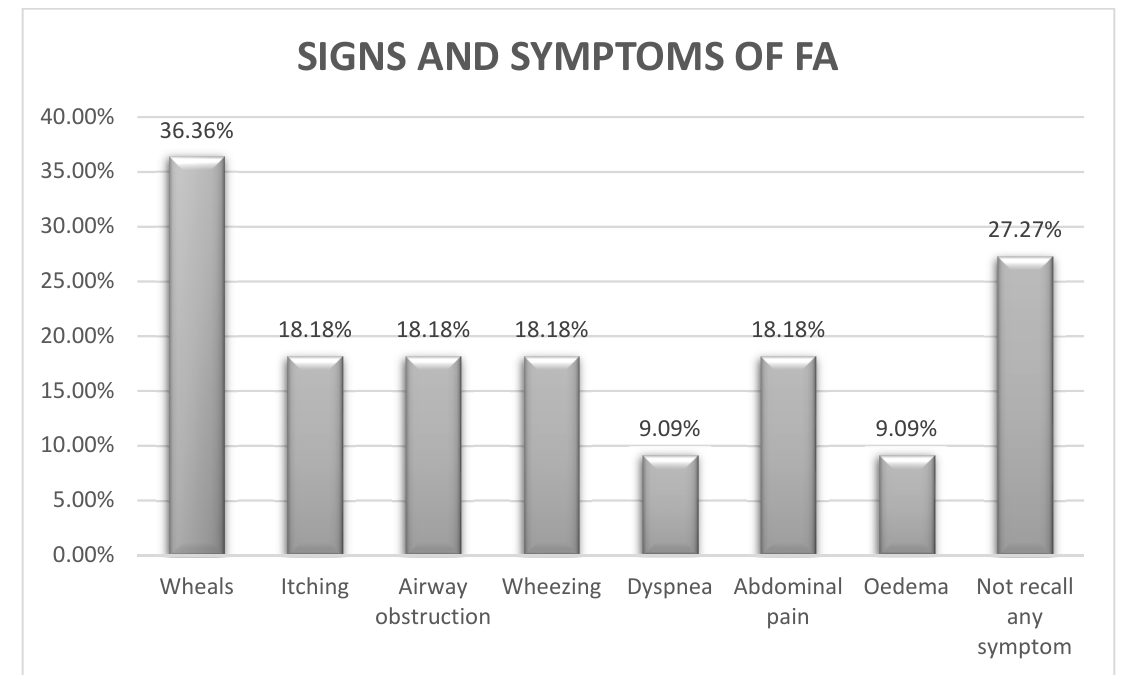
Figure 2. Different types of signs and symptoms of FA stated by teachers during an allergic reaction. Directions issued by the Ministry of Health on how to treat FA and anaphylaxis [16], were reported in 8/11 schools, but such directions were absent from, or were not used in 3/11 schools. Only 1/11 school enforced rules restricting the sharing of cutlery,